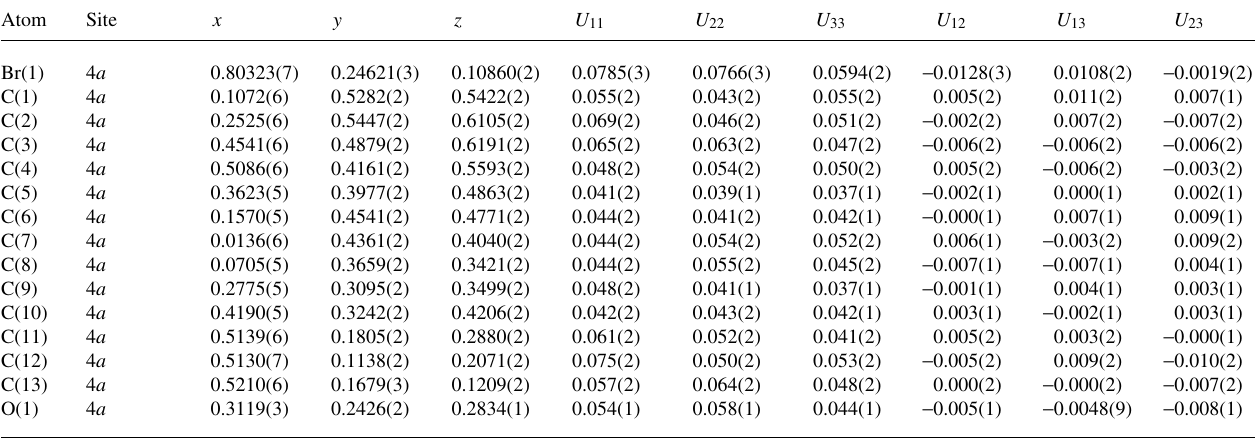
Table 3. Atomic coordinates and displacement parameters (in Å 2 )